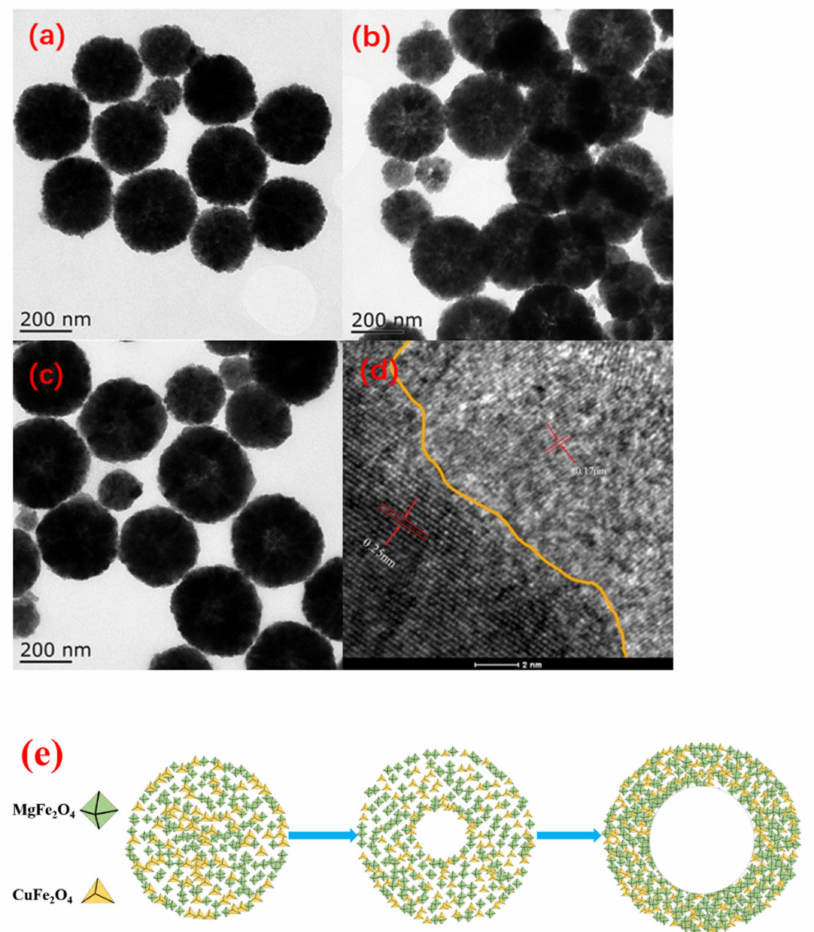
Figure 2. TEM images of (1:2) CuFe 2 O 4 /MgFe 2 O 4 : ( a ) 4 h with PEG; ( b ) 8 h with PEG; ( c ) 12 h with PEG; ( d ) HRTEM image; ( e ) schematic illustration (downward views) of the ripening process of the hollow